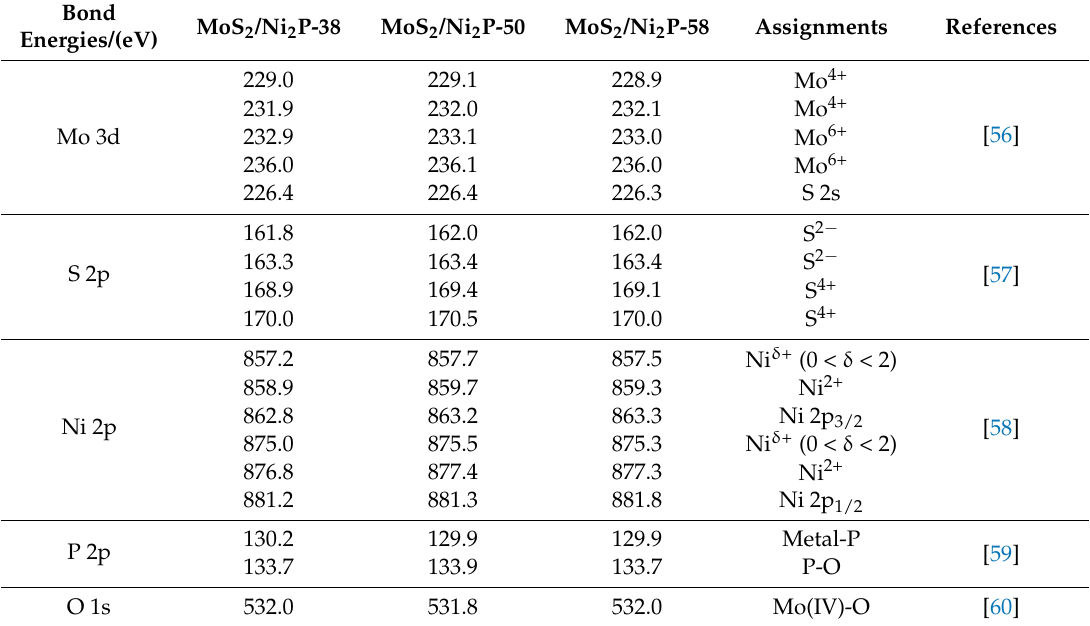
Table 1. Bond energies and assignments of Mo 3d, S 2p, Ni 2p, P 2p, and O 1s photoelectron peaks of three MoS 2 /Ni 2 P